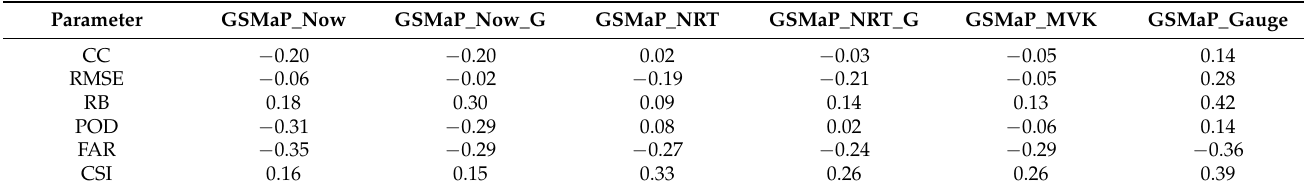
Table 9. Statistical parameter correlation value to altitude.